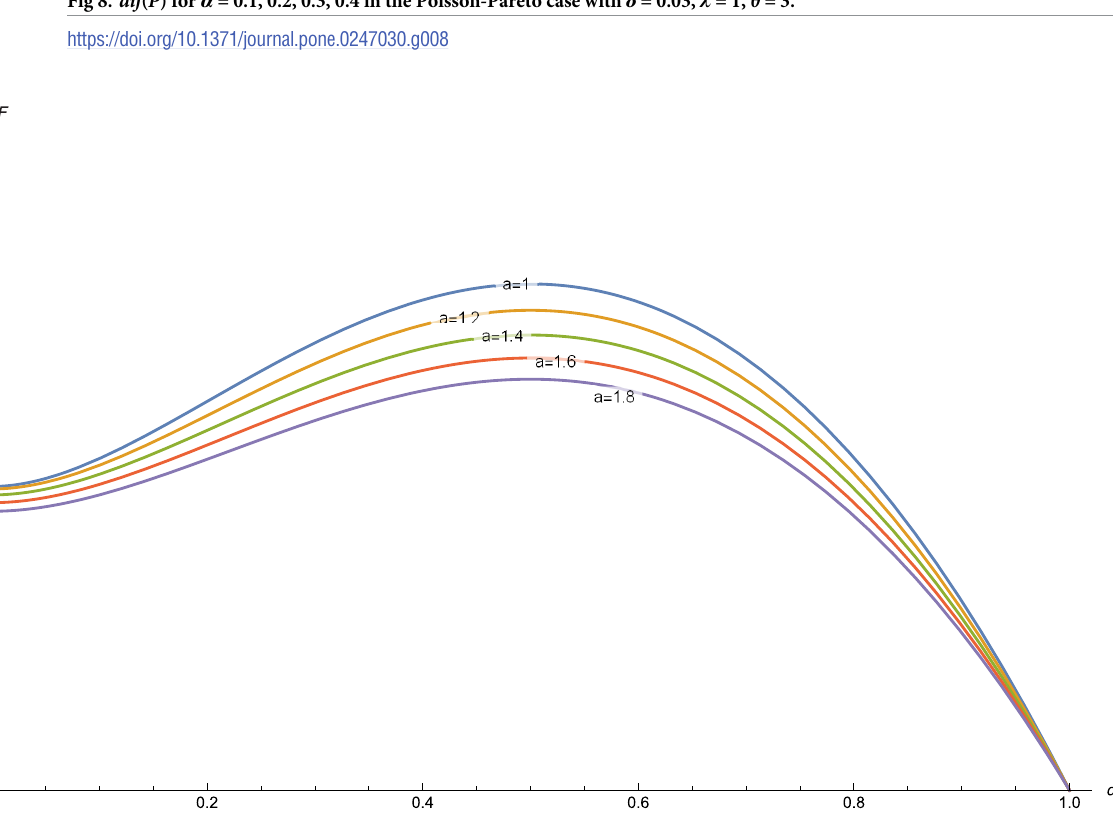
Fig 9. dif ( P ) for a = 1, 1.2, 1.4, 1.6, 1.8 in the Poisson-Pareto case with δ = 0.03, λ = 1, θ = 3.